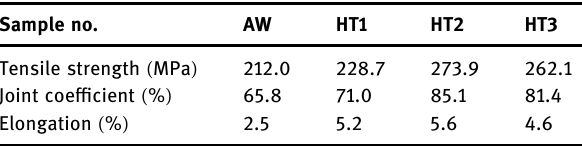
Table 3: Tensile test results of joints under di ff erent conditions Sample